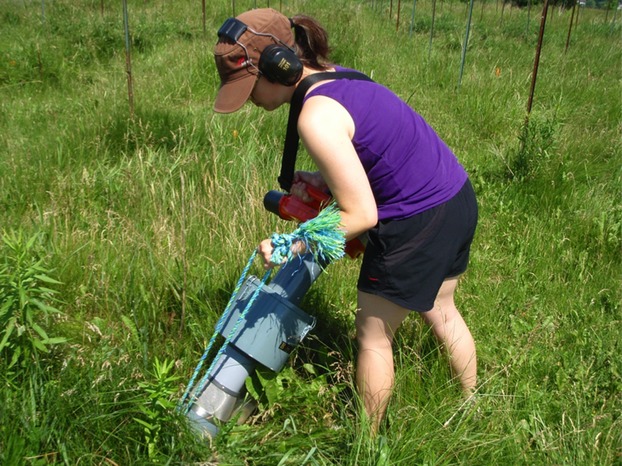
The invertebrate community associated with Schedonorus pratensis, S. arundinaceus, and unseeded plots was collected via vacuum sampling (shown above) in June 2010 and 2011. Photo credit: K. Shukla